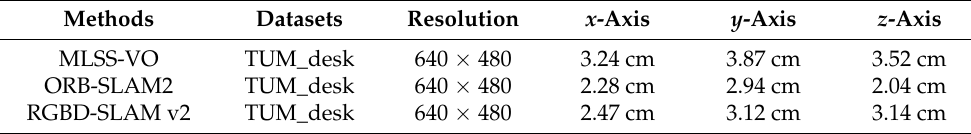
Table 4. Comparison of RMSE in MLSS-VO, ORB-SLAM2 and RGBD-SLAM v2 in TUM.